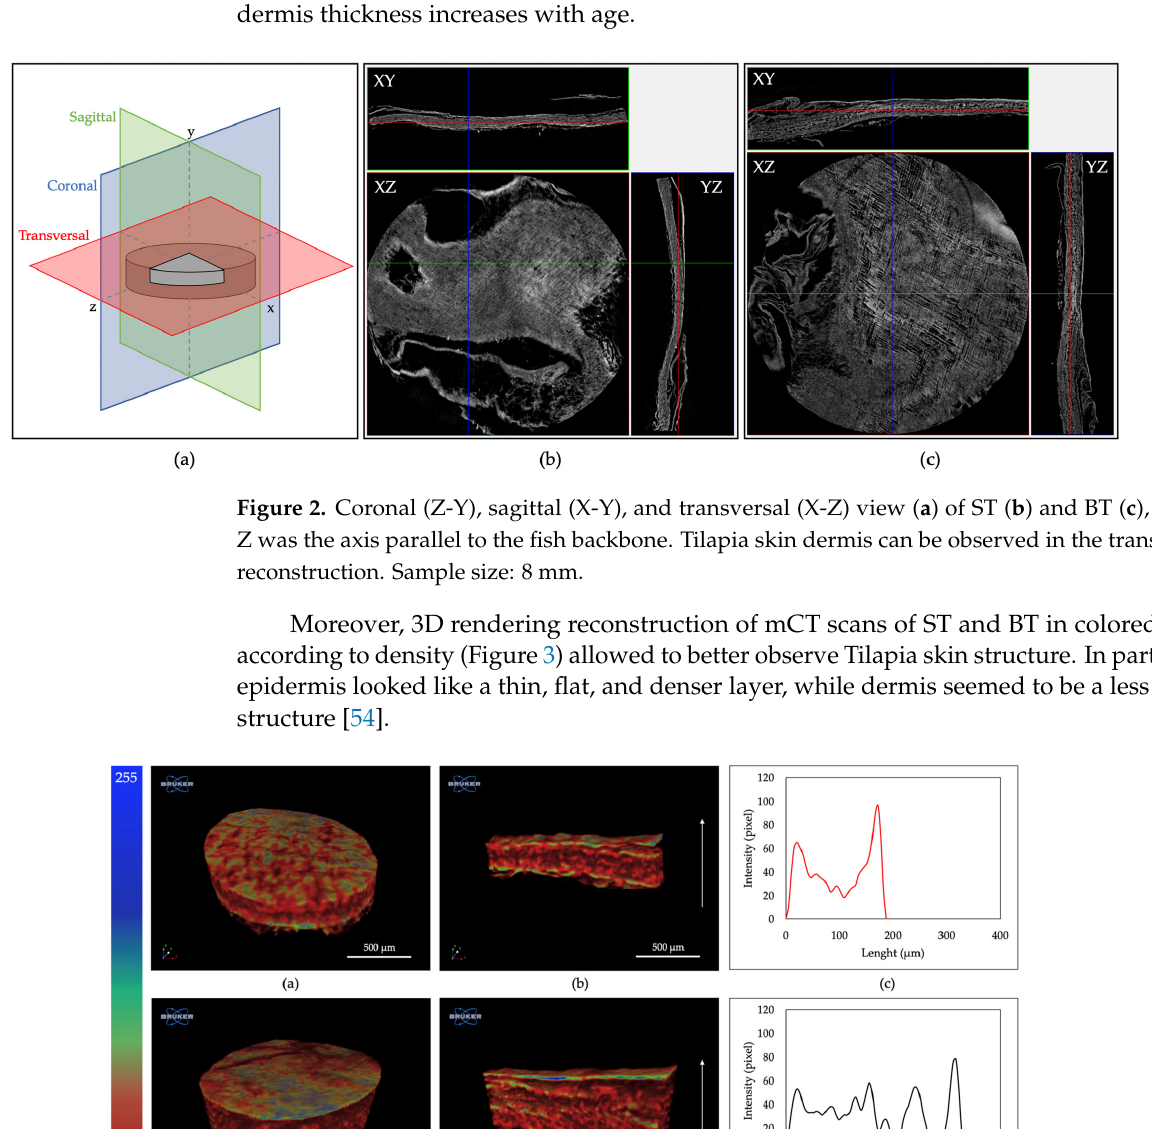
Figure 1. Representative DSC thermograms of ST and BT.